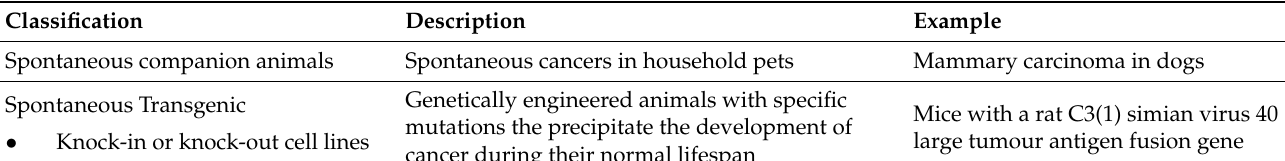
Table 1. Animal models of cancer